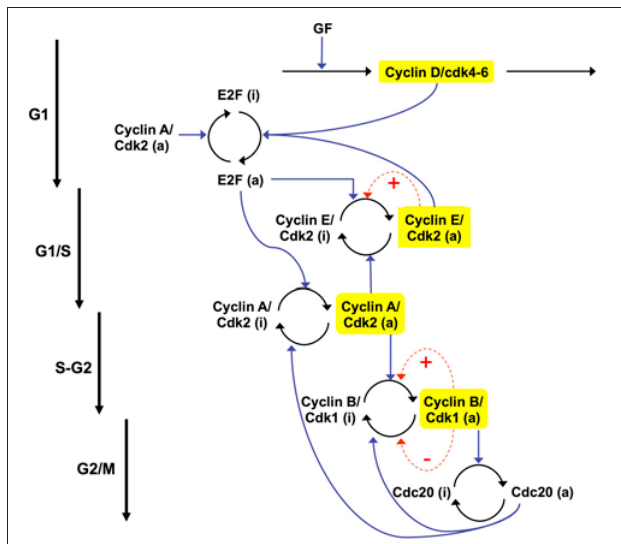
FIGURE 12 | Scheme of the extended skeleton model for the mammalian cell cycle (Gérard et al., 2012). The model contains the four main cyclin/Cdk complexes, the transcription factor E2F, and the protein Cdc20. Growth factor (GF) induces entry in the G1 phase of the cell cycle by promoting the synthesis of cyclin D/Cdk4–6. The latter complex allows the activation of E2F, which elicits the synthesis of cyclin E/Cdk2, at the G1/S transition, and cyclin A/Cdk2, during the S phase of DNA replication. During G2, cyclin A/Cdk2 also activates the synthesis of cyclin B/Cdk1, which elicits the peak of activity of cyclin B/Cdk1 at the G2/M transition. During mitosis, cyclin B/Cdk1 activates by phosphorylation the protein Cdc20. This creates a negative feedback loop in the activity of cyclin A/Cdk2 and cyclin B/Cdk1 by promoting the degradation of these complexes. The regulations exerted by Cdc20 allow the cell to complete mitosis, and to start a new cycle if GF is present in sufficient amount. In this version of the model, we consider that the total concentrations of cyclin E/Cdk2, cyclin A/Cdk2, and cyclin B/Cdk1 remain constant. These complexes can vary between an active (a) and an inactive (i) form. Moreover, positive feedback (PF) loops can be added in the regulation of cyclin E/Cdk2 and cyclin B/Cdk1, which control the G1/S and G2/M transitions (dashed arrows in red). These PF loops are due to the mutual activation between Cdk2, Cdk1, and their phosphatase Cdc25 and to the mutual inhibition between Cdk1 and the kinase